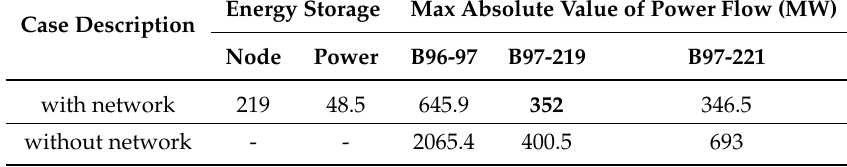
Table 9. Results with and without Transmission Network